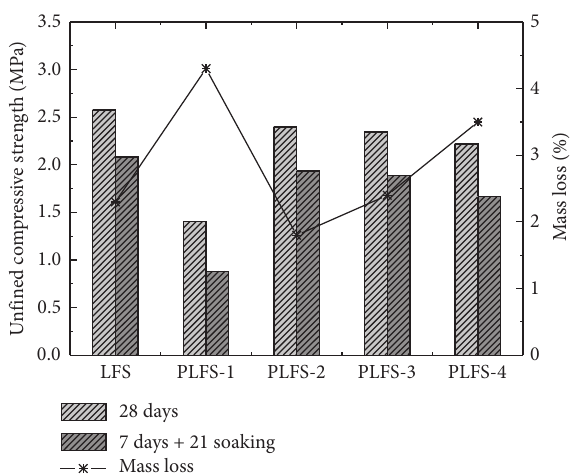
Figure 5: The influence of soaking on unconfined compressive strength.